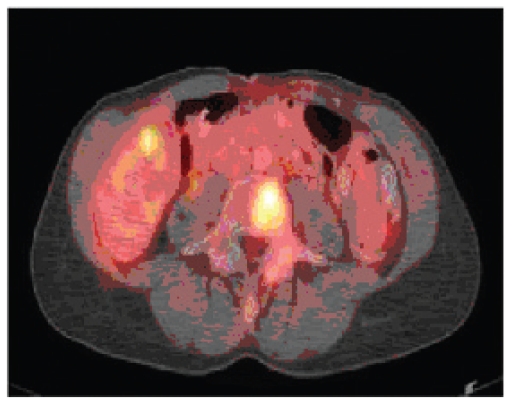
Before Treatment.